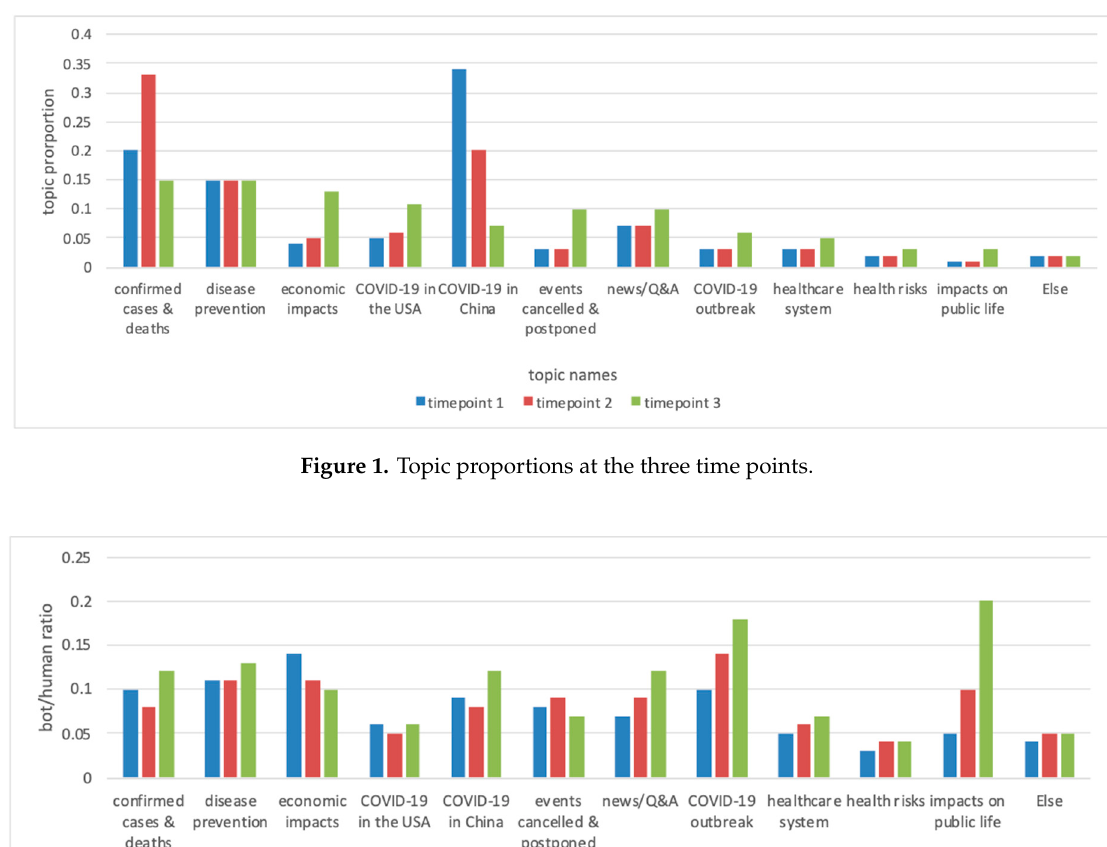
Table 2. Sentiments polarity and strength of all users, social bots, and humans for different topics.